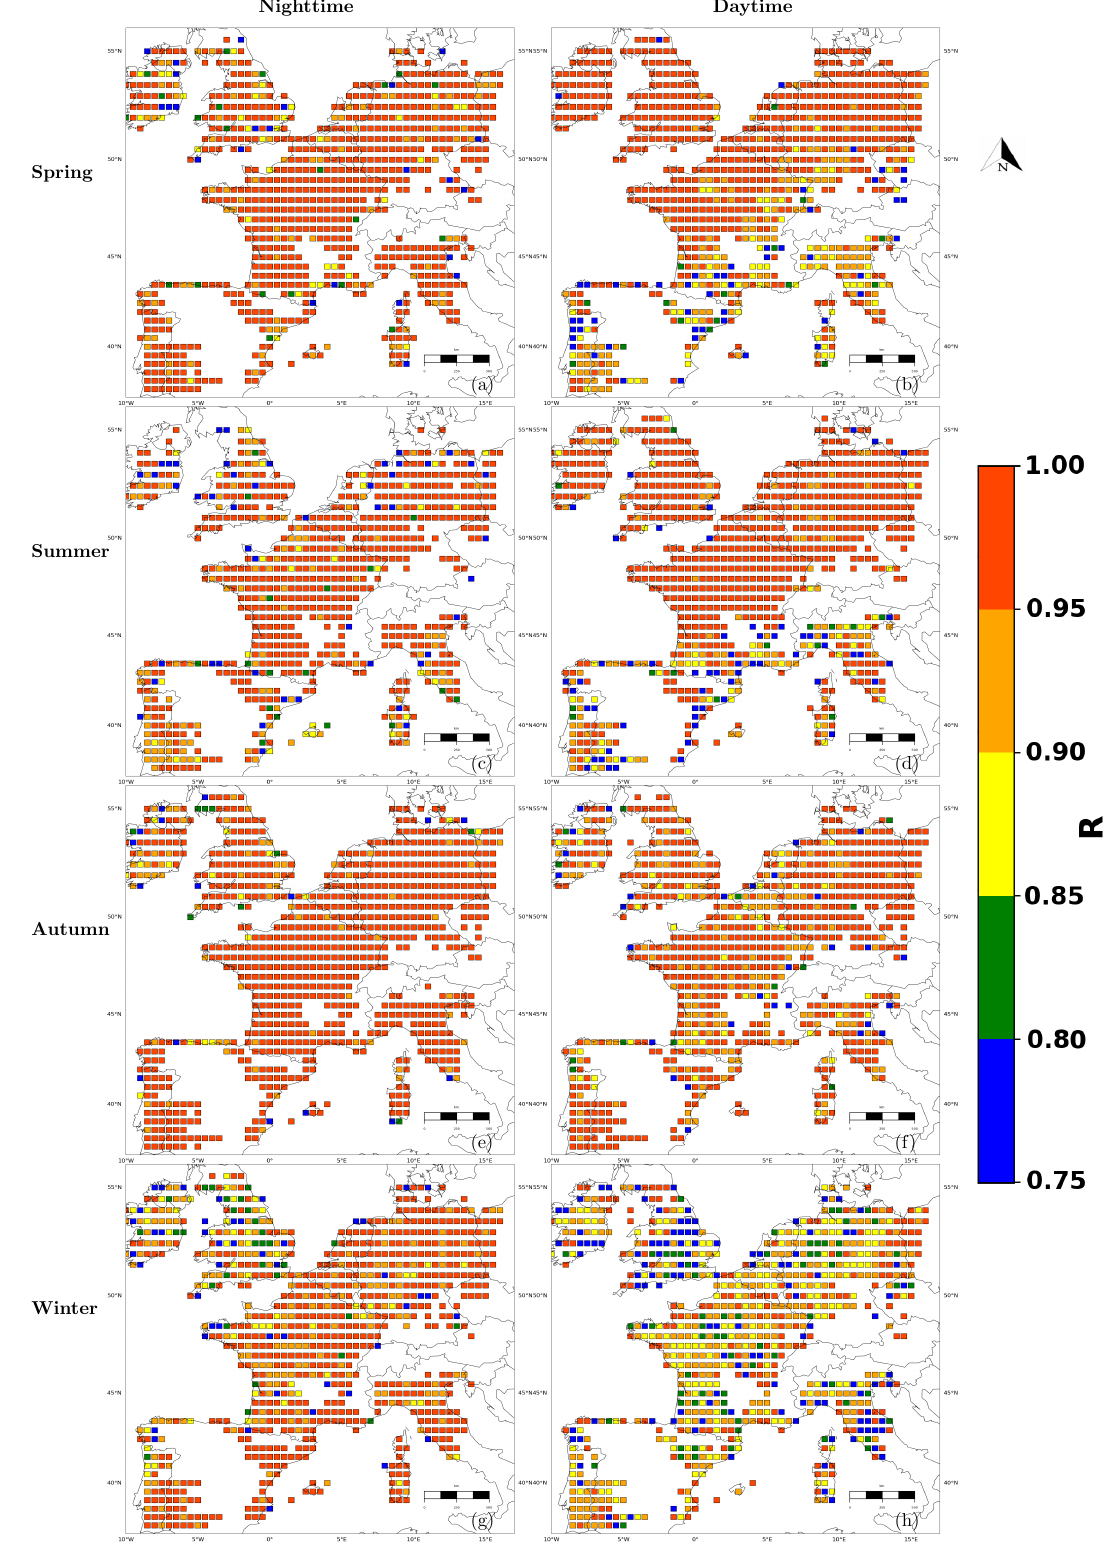
Figure 8. Correlation coefficients between IASI and SEVIRI Land Surface Temperature (in K) averaged on a 0.5 ◦ 0.5 ◦ resolution grid for: April/May 2018 by nighttime ( a ) and daytime ( b ); July/August × 2018 by nightime ( c ) and daytime ( d ); October/November 2018 by nighttime ( e ) and daytime ( f ); January/February 2018 by nighttime ( g ) and daytime ( h